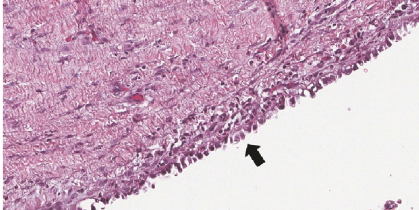
Figure 2: Microscopic examination shows a focus of endometriosis in the labial mass that lined by endometrial cells with cytologic atypia (10x).